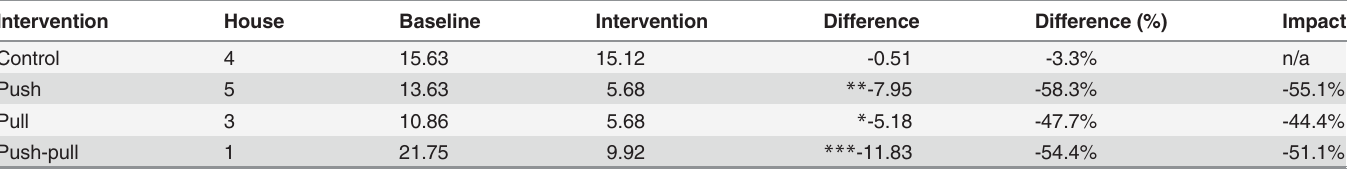
For the baseline data n = 8 (n = 7 for house 3) and n = 25 for the intervention data. Asterisks indicate a signi fi cant difference-in-differences between the control and the